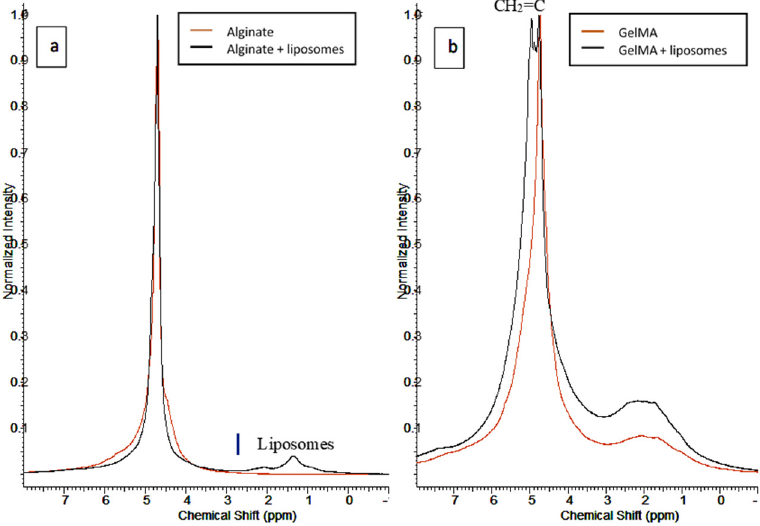
Figure 3. 1 HNMR spectra of ( a ) alginate and ( b ) GelMA before and after nanofunctionalization.